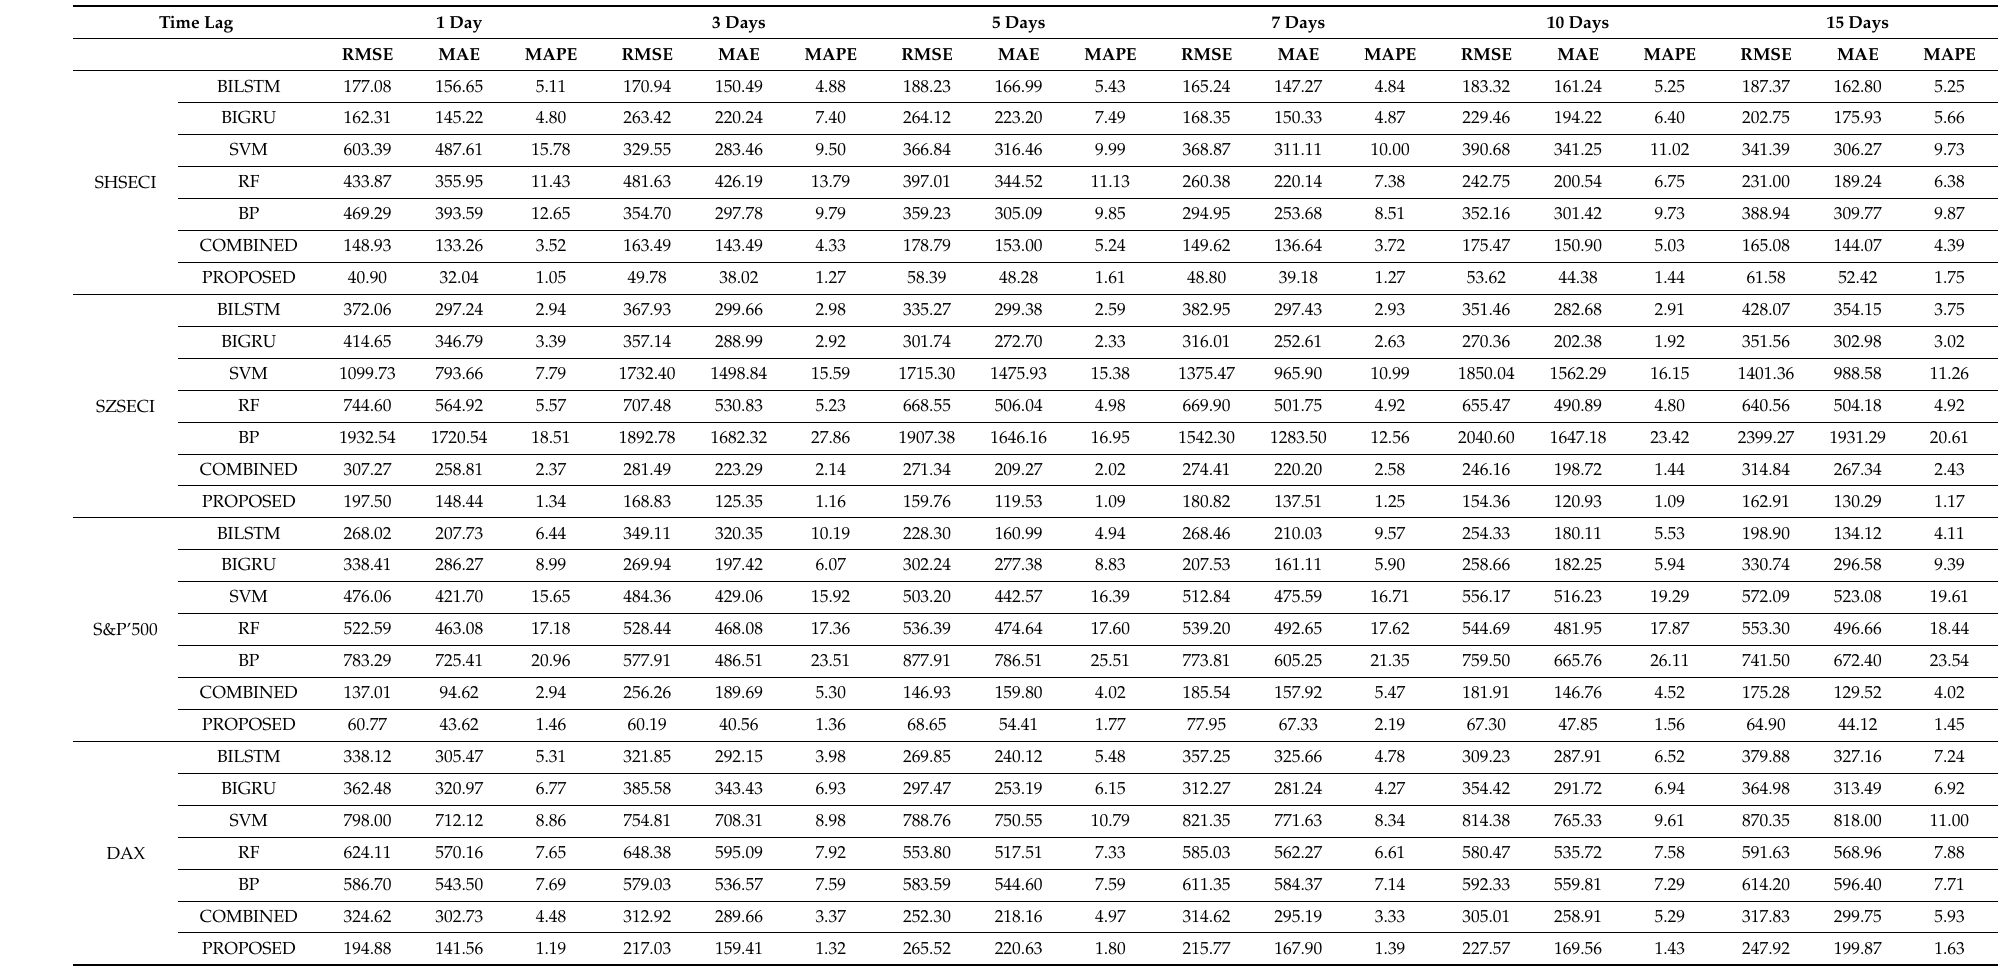
Table 3. Prediction errors of four stock